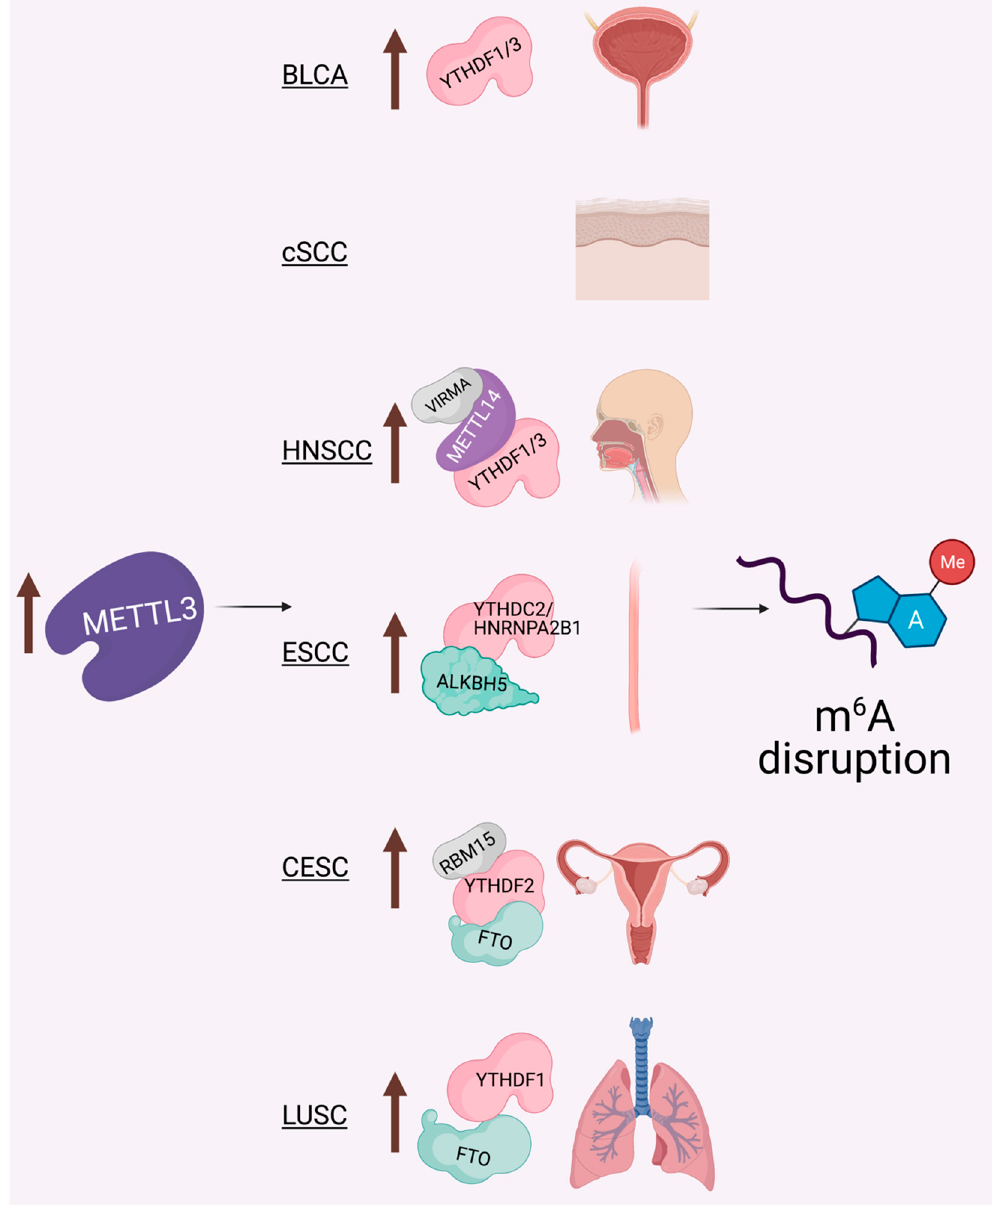
Figure 2. Epithelial cancers, and SCCs in particular, share numerous common biological underpinnings, including dysregulation of the METTL3-m 6 A epitranscriptome. To date, studies have demonstrated consistent overexpression of METTL3 across these cancers. As detailed further in the text and Table 1, depending upon the cancer, other writers (purple), readers (pink), erasers (green), and adaptors (gray) have been shown to display dysregulated expression or activity, ultimately driving m 6 A disruption and carcinogenesis through diverse mechanisms, such as oncogene activation or therapy resistance. Cancers listed include bladder cancer (BLCA), cutaneous SCC (cSCC), head and neck SCC (HNSCC), esophageal SCC (ESCC), cervical SCC (CESC), and lung SCC (LUSC).